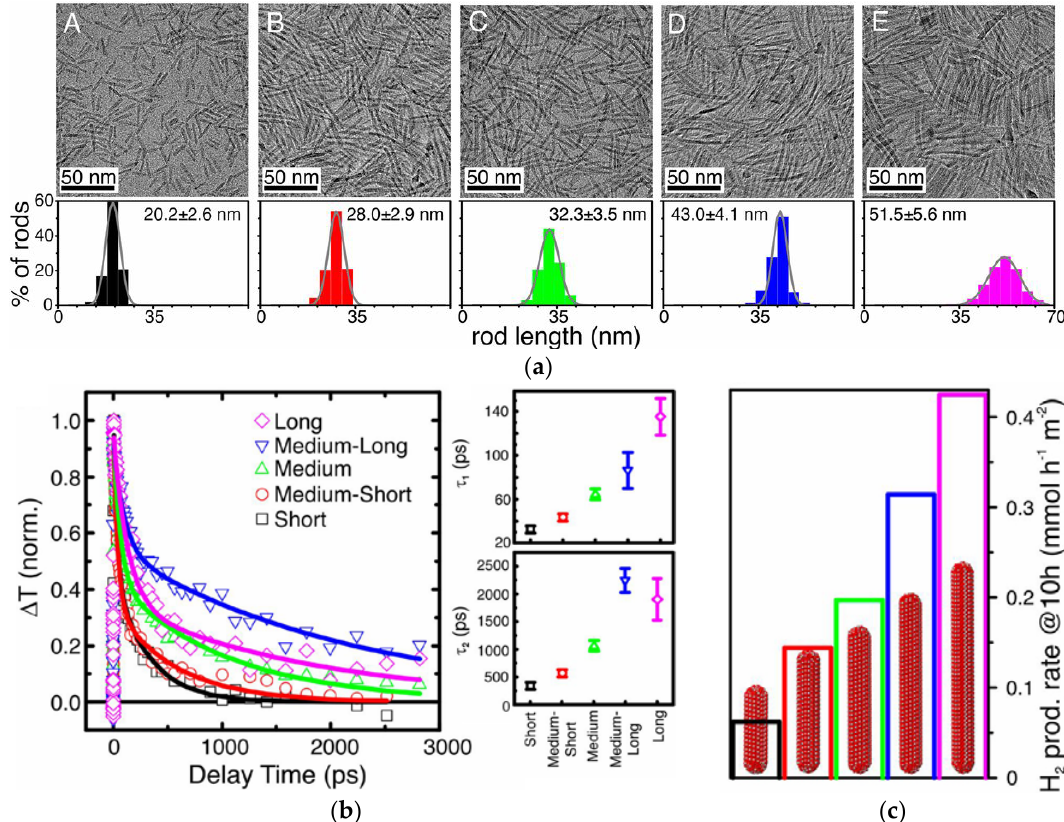
Figure 4. ( a ) TEM images and size analysis for the brookite nanorods with different lengths; ( b ) Normalized TRAS (time-resolved vis-IR absorption spectroscopy) kinetic traces of Pt-decorated nanorods in ethanol. Insets show fitted time constants ( τ 1 (Top) and τ 2 (Bottom)); ( c ) H 2 production rates from ethanol photoreforming on 1 wt. % Pt−brookite nanorods of different length after 10 h under illumination, normalized by the surface area of the photocatalysts. Reproduced from reference [28] with the permission of the PNAS, 2017.